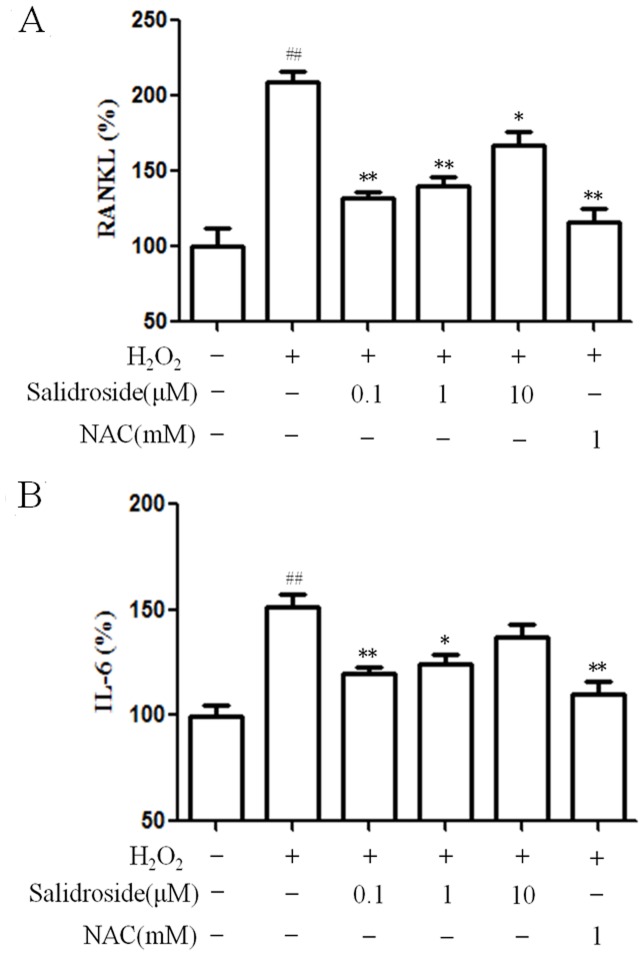
Inhibition of salidroside on RANKL and IL-6 production of MC3T3-E1 cells in the presence of H2O2.After differentiation induction of 6 days, MC3T3-E1 cells were pretreated with salidroside for 24 h before treatment with 0.3 mM H2O2 for 24 h. NAC was used as positive control. A: The production of RANKL in the presence of salidroside and/or H2O2. The control value for RANKL was 3.792±0.271ng/mg. B: The production of IL-6 in the presence of salidroside and/or H2O2. The control value for IL-6 was 0.429±0.391 ng/mg. ##
P<0.01 versus untreated control cells;*P<0.05 and **P<0.01 compared with the group treated with H2O2 alone.